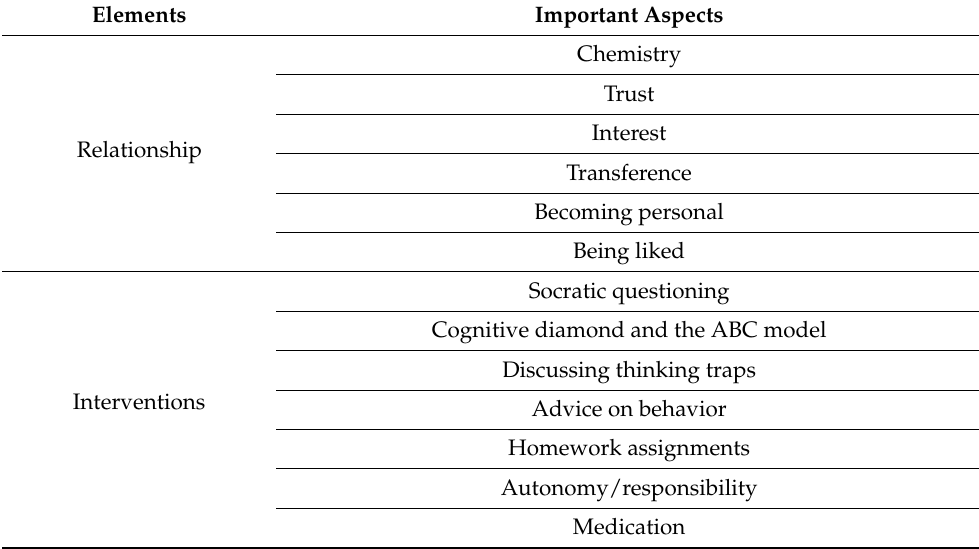
Table 3. Elements and important aspects, as experienced by patients, are